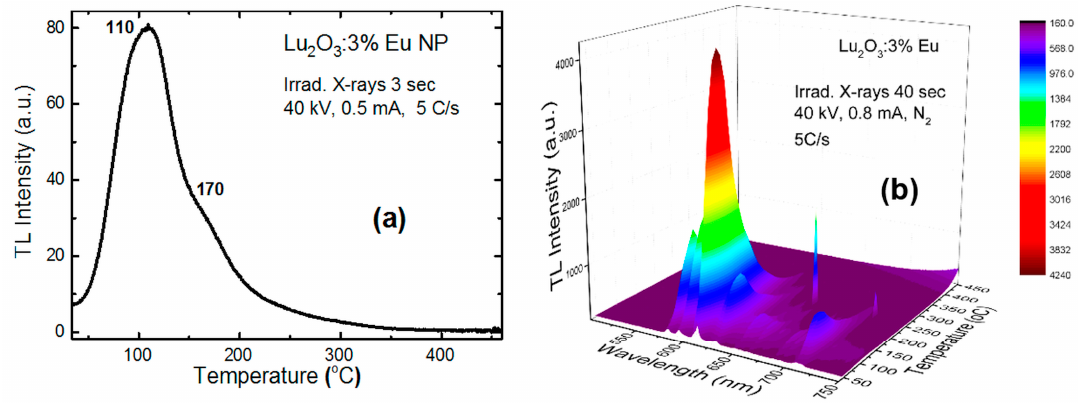
Figure 6. Thermally stimulated luminescence (TSL) glow curve ( a ) and TSL emission spectra ( b ) of Lu 2 O 3 :Eu NP after irradiation by X-ray at 300 K. The two spikes at ~650 nm and 730 nm around ◦ C in (b) are artifacts due to an electronic noise of CCD. 260–270 °C in (b) are artifacts due to an electronic noise of CCD. 260–270